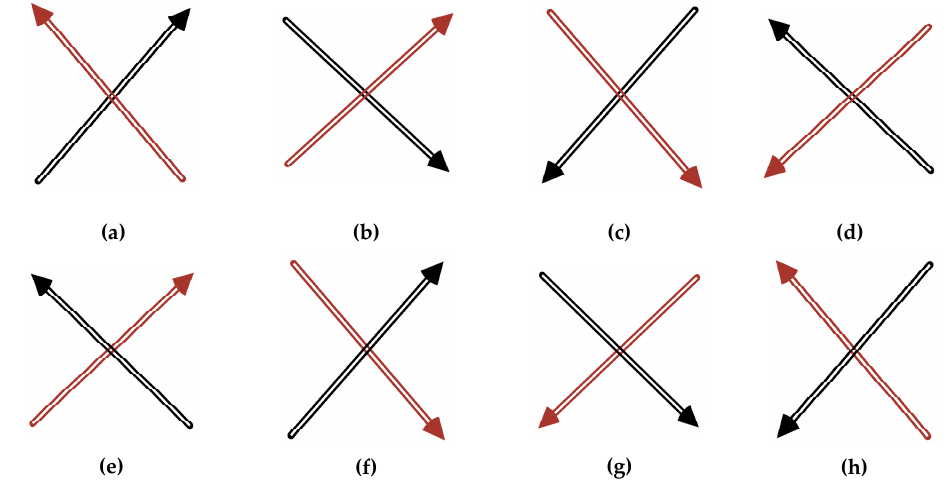
Figure 5. The eight rotate and flip patterns for an image. ( a ) the initial state; ( b ) rotate 90 degrees clockwise; ( c ) rotate 180 degrees clockwise; ( d ) rotate 270 degrees clockwise; ( e ) right left flip; ( f ) right left flip and rotate 90 degrees clockwise; ( g ) right left flip and rotate 180 degrees clockwise; ( h ) right left flip and rotate 270 degrees clockwise.